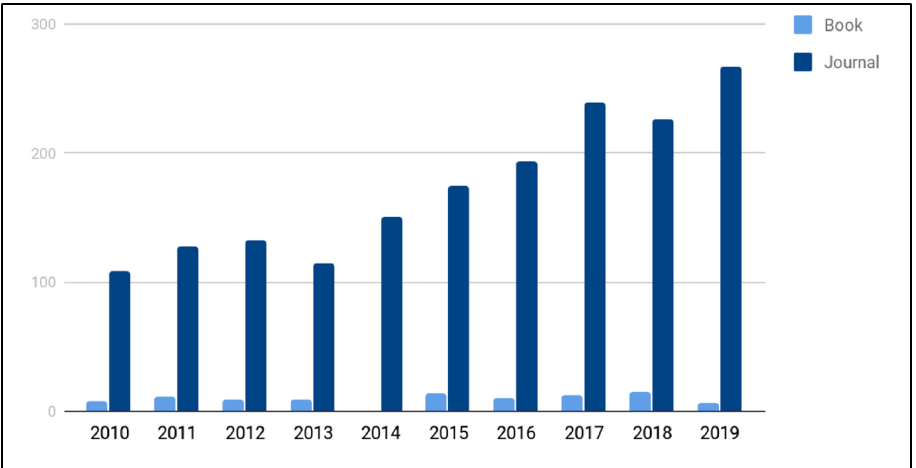
Figure 1. Books and articles published on design thinking.